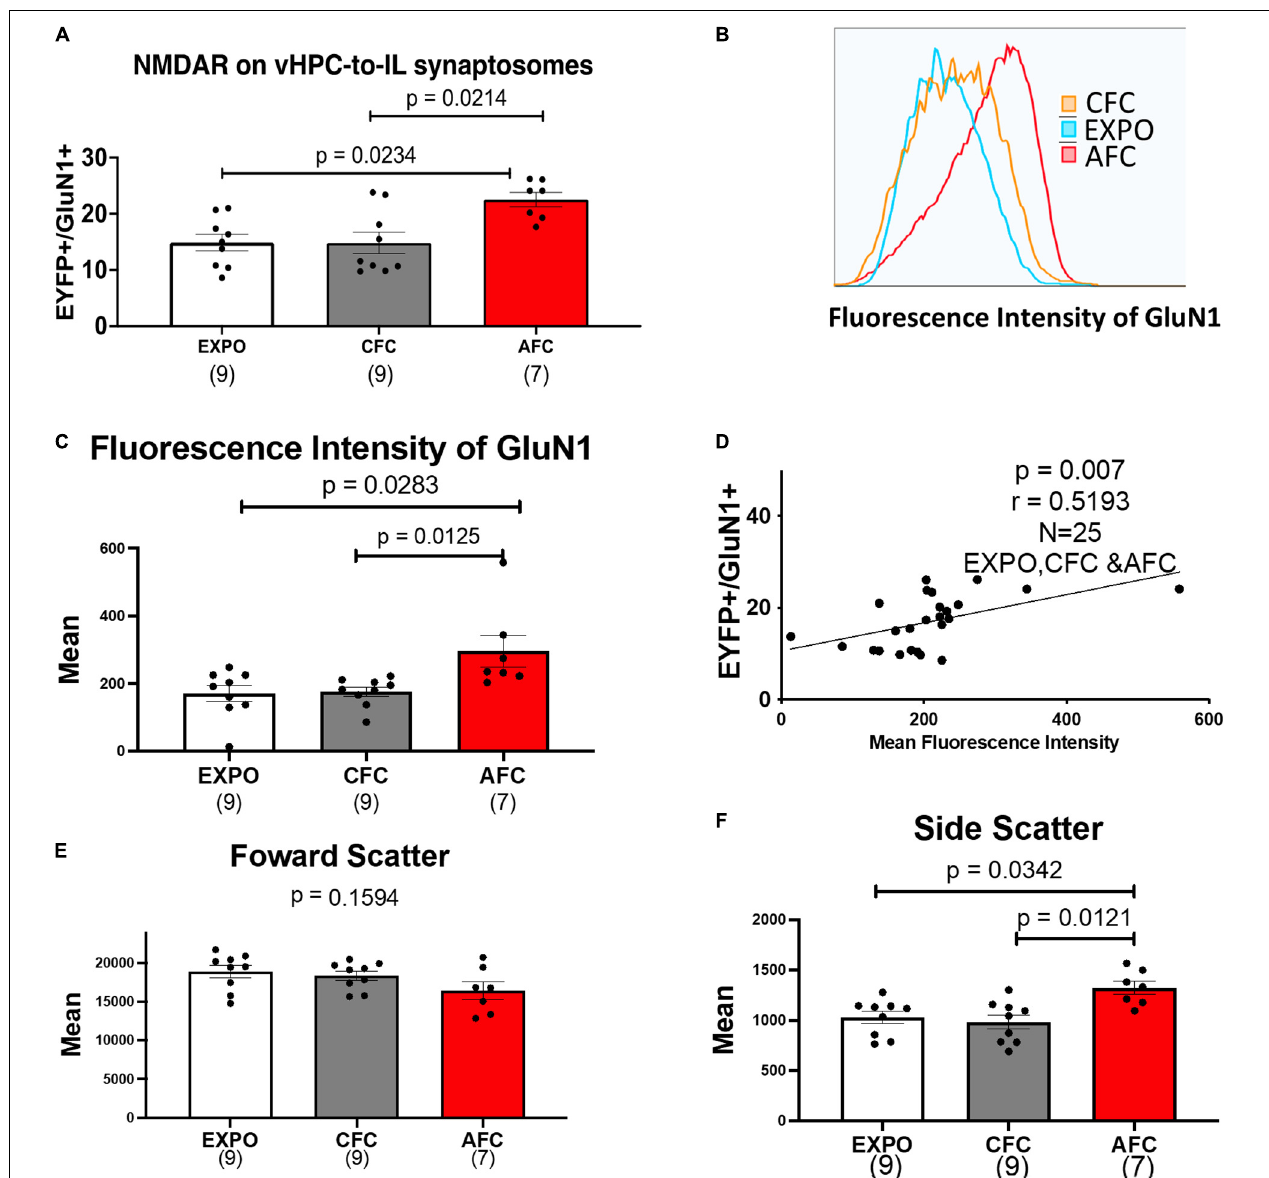
FIGURE 3 | AFC increases the number of NMDARS on VHPC-to-IL synaptosomes in males. (A) Relative levels of EYFP+/GluN1+ synaptosomes in male behavioral groups. (B) Representative histogram of the fluorescence intensity of GluN1 on EYFP+/GluN1+ synaptosomes from a single sample from the Exposure, CFC, and AFC male groups. (C) Mean fluorescence intensity of GluN1 on EYFP+/GluN1+ synaptosomes in male groups. (D) Correlation between the levels of EYFP+/GluN1+ synaptosomes and the mean fluorescence intensity of GluN1 in the male samples. (E) Mean forward scatter of the EYFP+/GluN1+ synaptosomes in the male groups. (F) Mean side scatter of the EYFP+/GluN1+ synaptosomes in the male groups. Sample sizes are indicated below each bar.